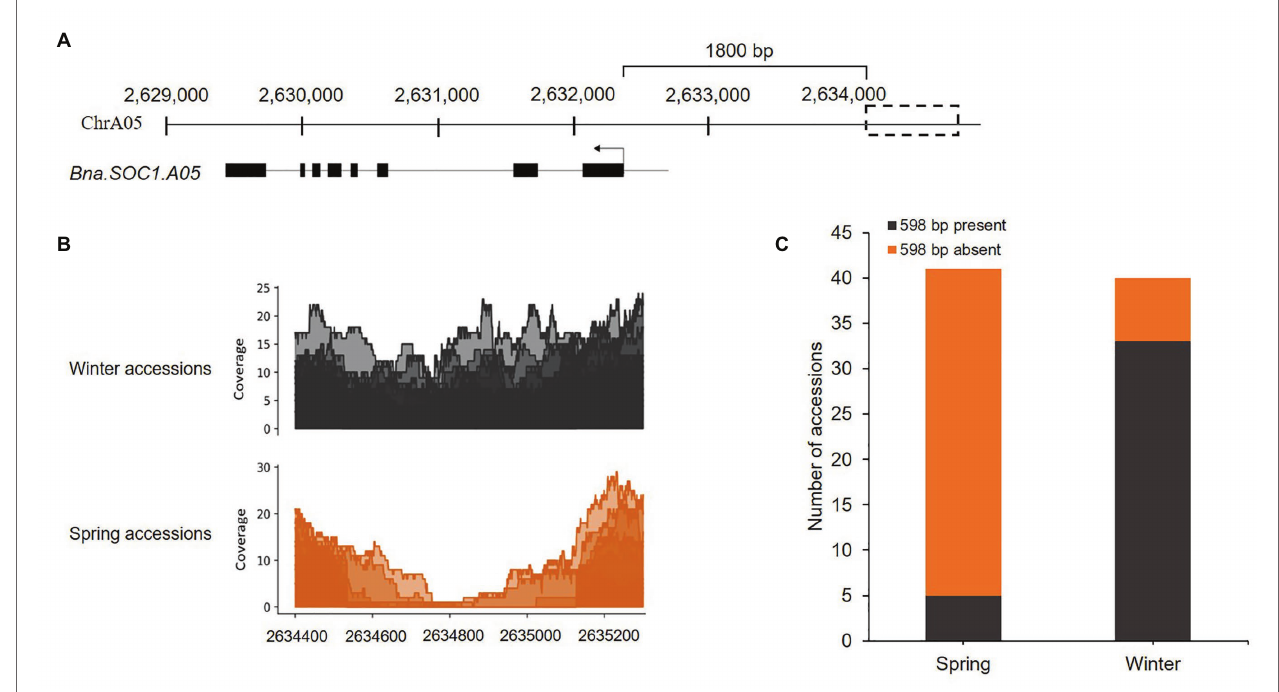
FIGURE 1 | Presence/absence variation (PAV) upstream of Bna.SOC1.A05 is associated with growth type. (A) Genomic region harboring Bna.SOC1.A05 and the PAV in Express617 genome (dotted box). (B) Per base depth of coverage in the region 2,634,400 to 2,635,200, showing drop in coverage in the spring accessions. (C) Stack plot showing the presence of the insertion in 85% of the winter accession and deletion in 87% of the spring accessions